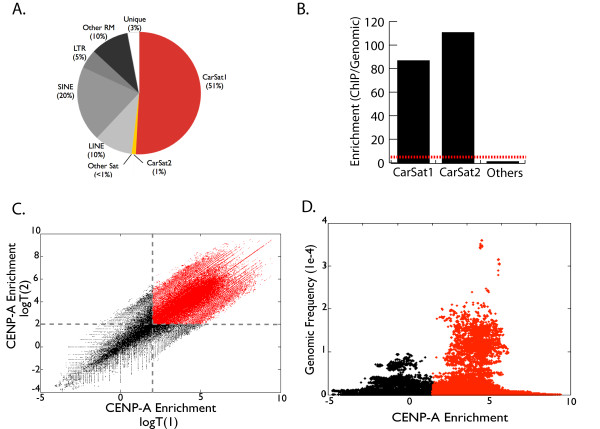
Characterizing functional satellite sequence features. Centromere sequence features associated with CENP-A ChIP sequences. (A) Reads were initially mapped to canFam2.0 and characterized relative to sequence classification, as indicated in pie graph. (B) Both CarSat1 and CarSat2 are highly enriched in the CENP-A ChIPseq dataset (p < 0.01) relative to genomic background estimates (as demonstrated by red dotted line). Other satellite families showed no evidence of enrichment and are combined into one data point. (C) CarSat satellite families (CarSat1 and CarSat2) show enrichment of select sequences in the CENP-A ChIP dataset on an xy-plot of two replicate enrichment estimates (log transformed relative enrichment scores), highlighting in red in the upper right quadrant those k-mers that are enriched in both comparisons as delineated with grey dotted lines. (D) CarSat k-mers that are enriched (red) compared to those that are not enriched (black), as a function of their observed frequency in the genome. Both high-copy and low-copy number k-mers are enriched in both satellite families.